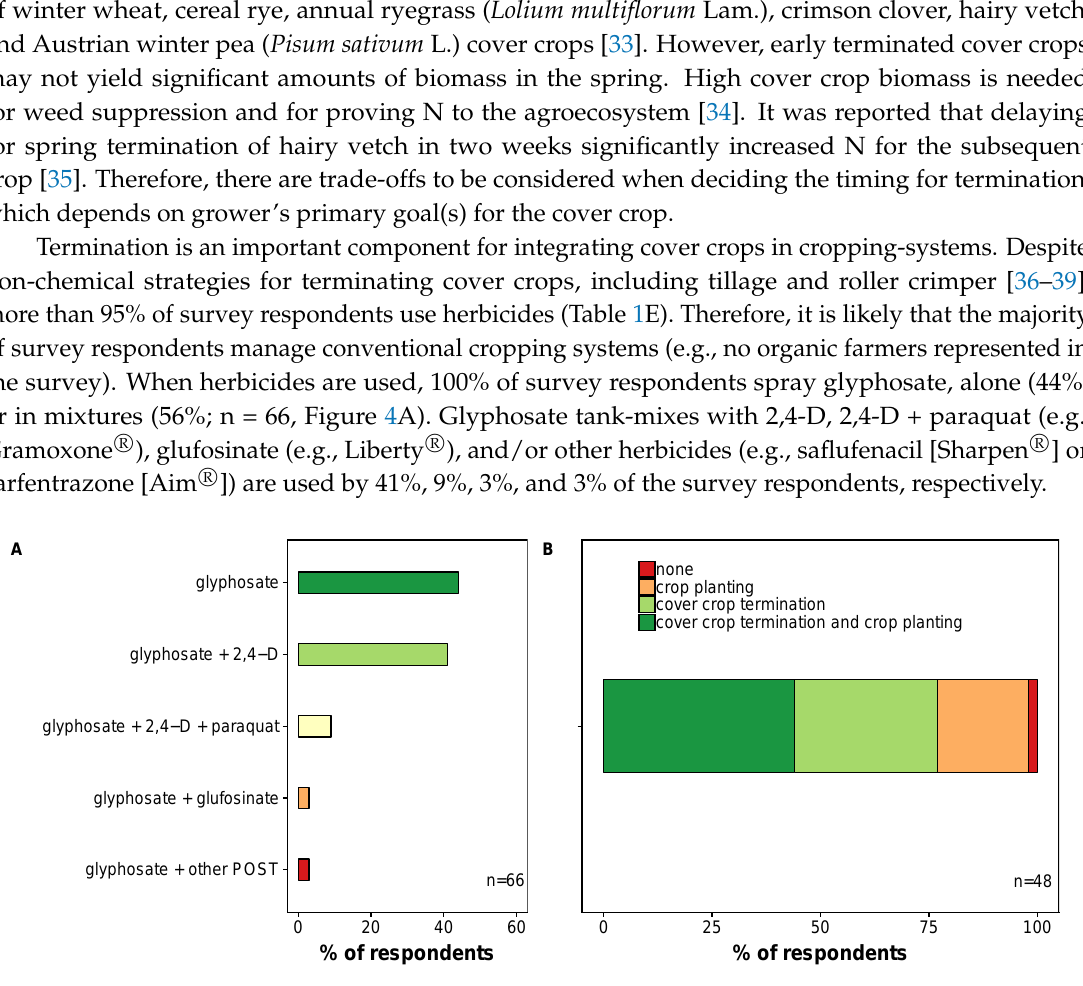
Figure 4. Herbicide programs used for cover crop termination ( A ) and timing for pre-emergence herbicide application ( B ) according to Nebraska survey